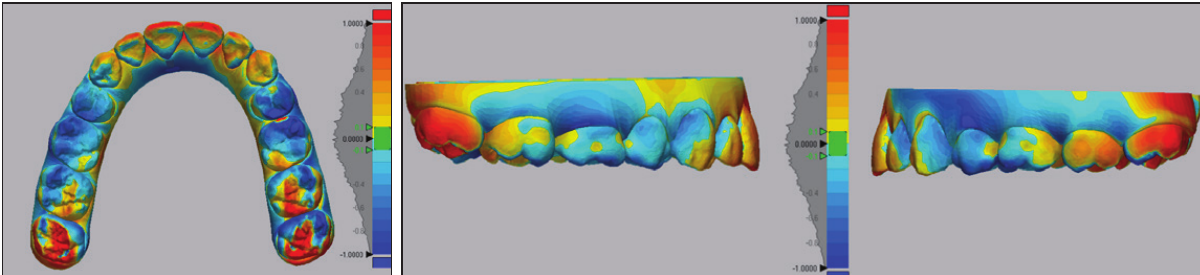
Figure 13. 3D heat map demonstrating accuracy of tooth